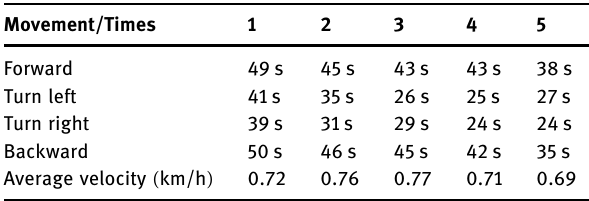
Table 1: Experimental data and analysis